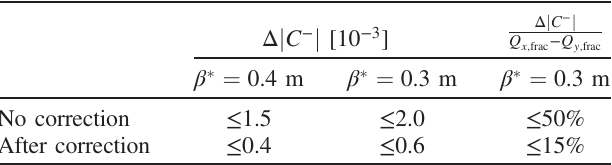
TABLE IV. Maximum possible change to j C − j which can be generated via normal-sextupole/skew-octupole feed-down in IR1 (ALTAS) during crossing angle leveling. Values for β (cid:1) ¼ 0 . 3 m are based on the expected scaling of the feed-down with β (cid:1) . The largest possible value from either Beam 1 or Beam 2 is shown.